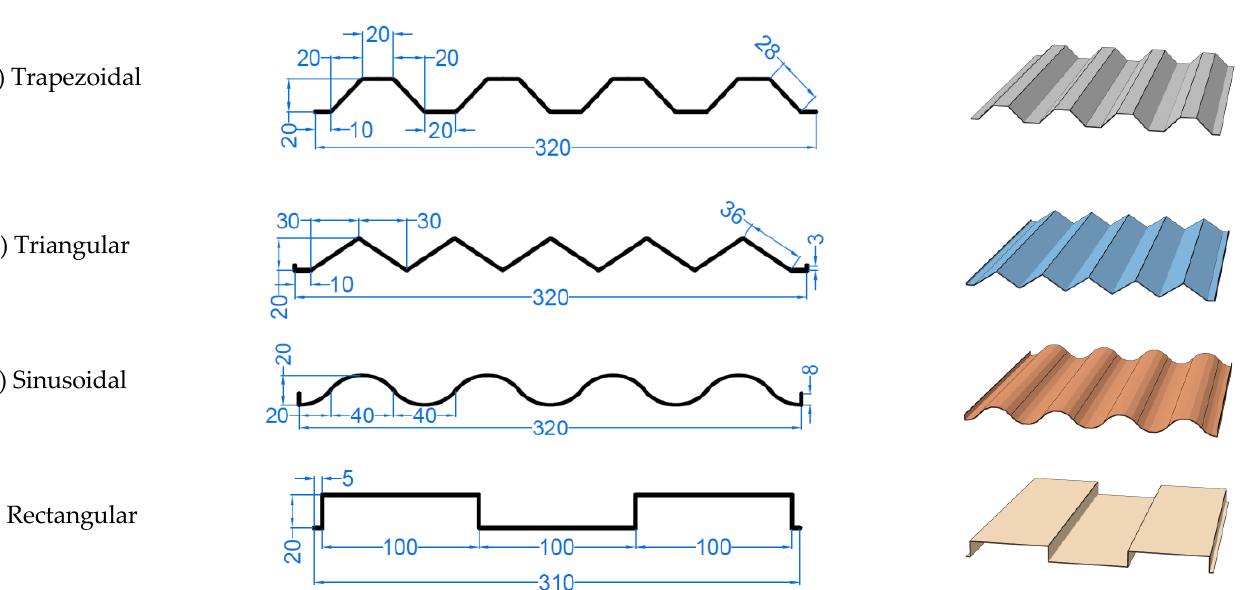
Figure 2. Cross-sectional dimensions (mm) and 3D views of the topologies covered in this paper. ( a ) Trapezoidal; ( b ) Triangular; ( c ) Sinusoidal; ( d ) Rectangular.